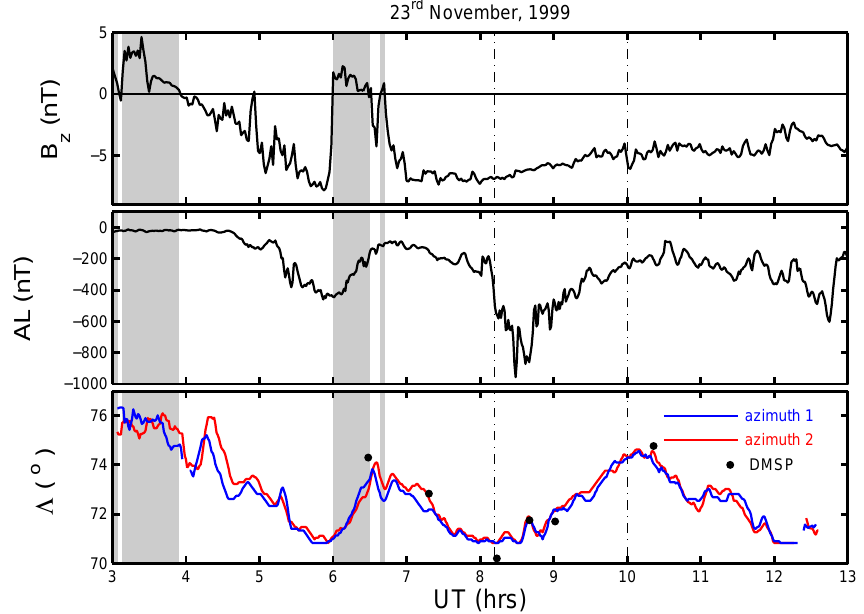
Fig. 3. (Top) The B Z component of the IMF in the GSM coordinate system, observed by the WIND spacecraft, lagged by the predicted propagation time from the satellite to the dayside magnetopause. (Middle) The auroral AL index. (Bottom) The latitude of the polar cap boundary determined from (in blue) beam 1 (azimuth 344 ◦ E of N, along the geomagnetic meridian) and (in red) beam 2 (azimuth 359 ◦ E of N, along the geographic meridian) of the EISCAT VHF radar operated in the CP-4-B mode (as shown in Fig. 2). The black points are the open closed boundary intersections seen by DMSP satellites at an MLT within 1.5h of that of beam 1 of the EISCAT radar. The areas shaded grey are northward IMF and the vertical dot-dashed lines mark the expansion/recovery phases of the larger substorm.